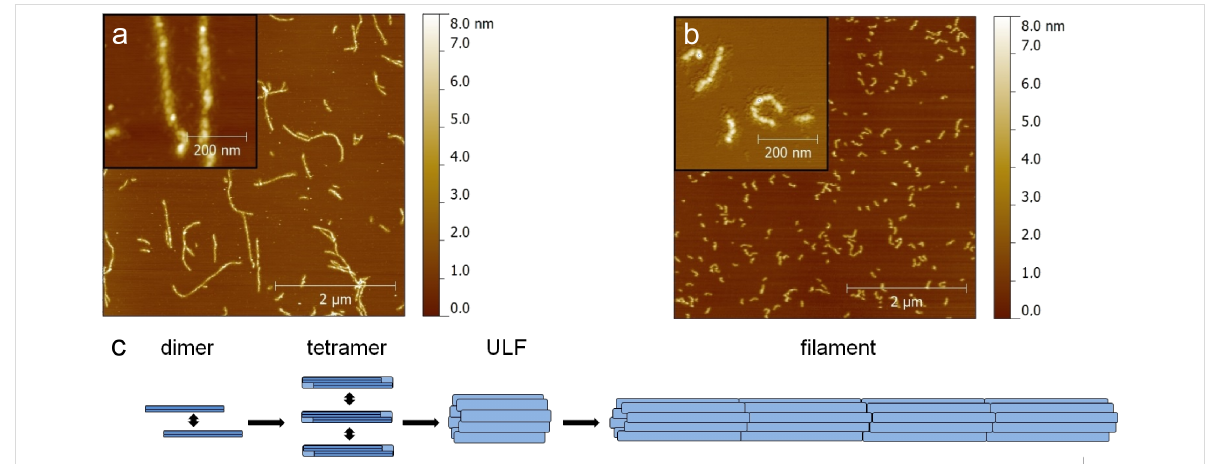
Figure 1: AFM topography scans of desmin filaments under ambient conditions. a) Filaments assembled from wild-type proteins are several microme- ters long and expose a vague right handed twist. b) Filaments assembled from mutated desmin protein (deletion mutation p.E114del, for details see [22]) are significantly shorter and show a completely different surface morphology. c) Assembly model of type II intermediate filaments [24]. Desmin monomers associate to parallel coiled coil dimers. Dimers form antiparallel tetramers which assemble to unit length filaments (ULF). Filaments elon- gate by longitudinal assembly of ULF.